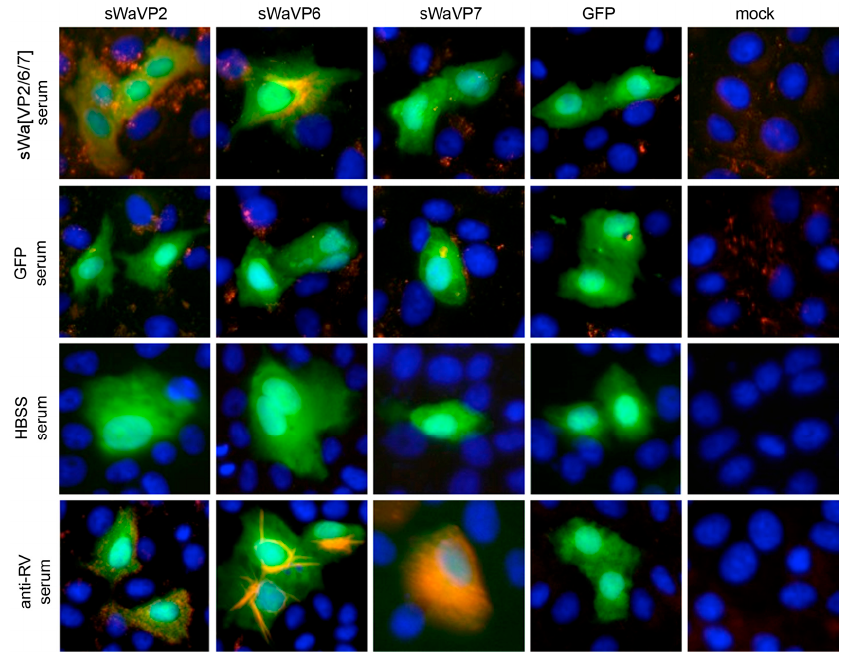
Figure 4. Screening of mice sera using immune fluorescence show VP2- and VP6-specific antibodies in the sera of vaccinated dams. Vero2-2 cells transduced (MOI 1) with the corresponding monocistronic amplicon vectors encoding individual RV proteins VP2, VP6 or VP7 were stained 24 hpt by immune fluorescence. The sera of vaccinated dams served as primary antibodies (diluted 1:100) and were detected by the secondary antibody anti-mouse conjugated with Alexa-Fluor 594 (red). GFP fluorescence (green) expressed as reporter gene from each amplicon vector served to identify transduced cells, DAPI was used to stain the nuclei (blue). Polyclonal anti-RV serum served as positive control.